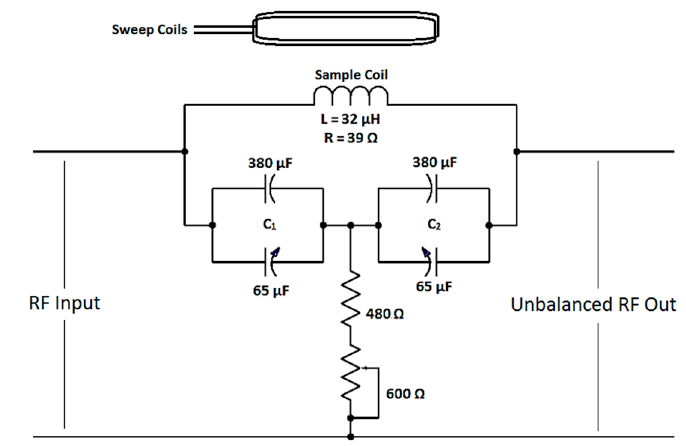
Figure 2. An example bridge circuit used in an early magnetometer to determine magnetic field strength.